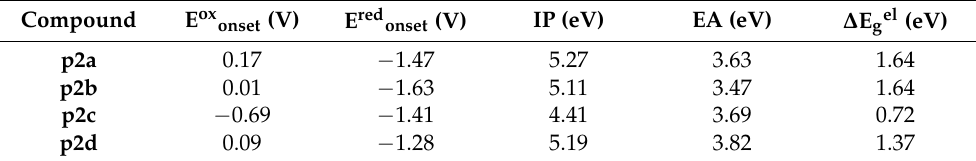
Table 3. Redox properties of polymers. E ox onse t —oxidation peak onset ; E red onset —reduction peak onset ; IP—ionization potential, estimated from the equation IP [eV] = |e|5.1 + E ox onset [V]; EA—electron affinity, estimated from the equation EA [eV] = |e|5.1 + E red onset [V]; ∆ E gel —electrochemical bandgap, from the equation ∆ E gel =